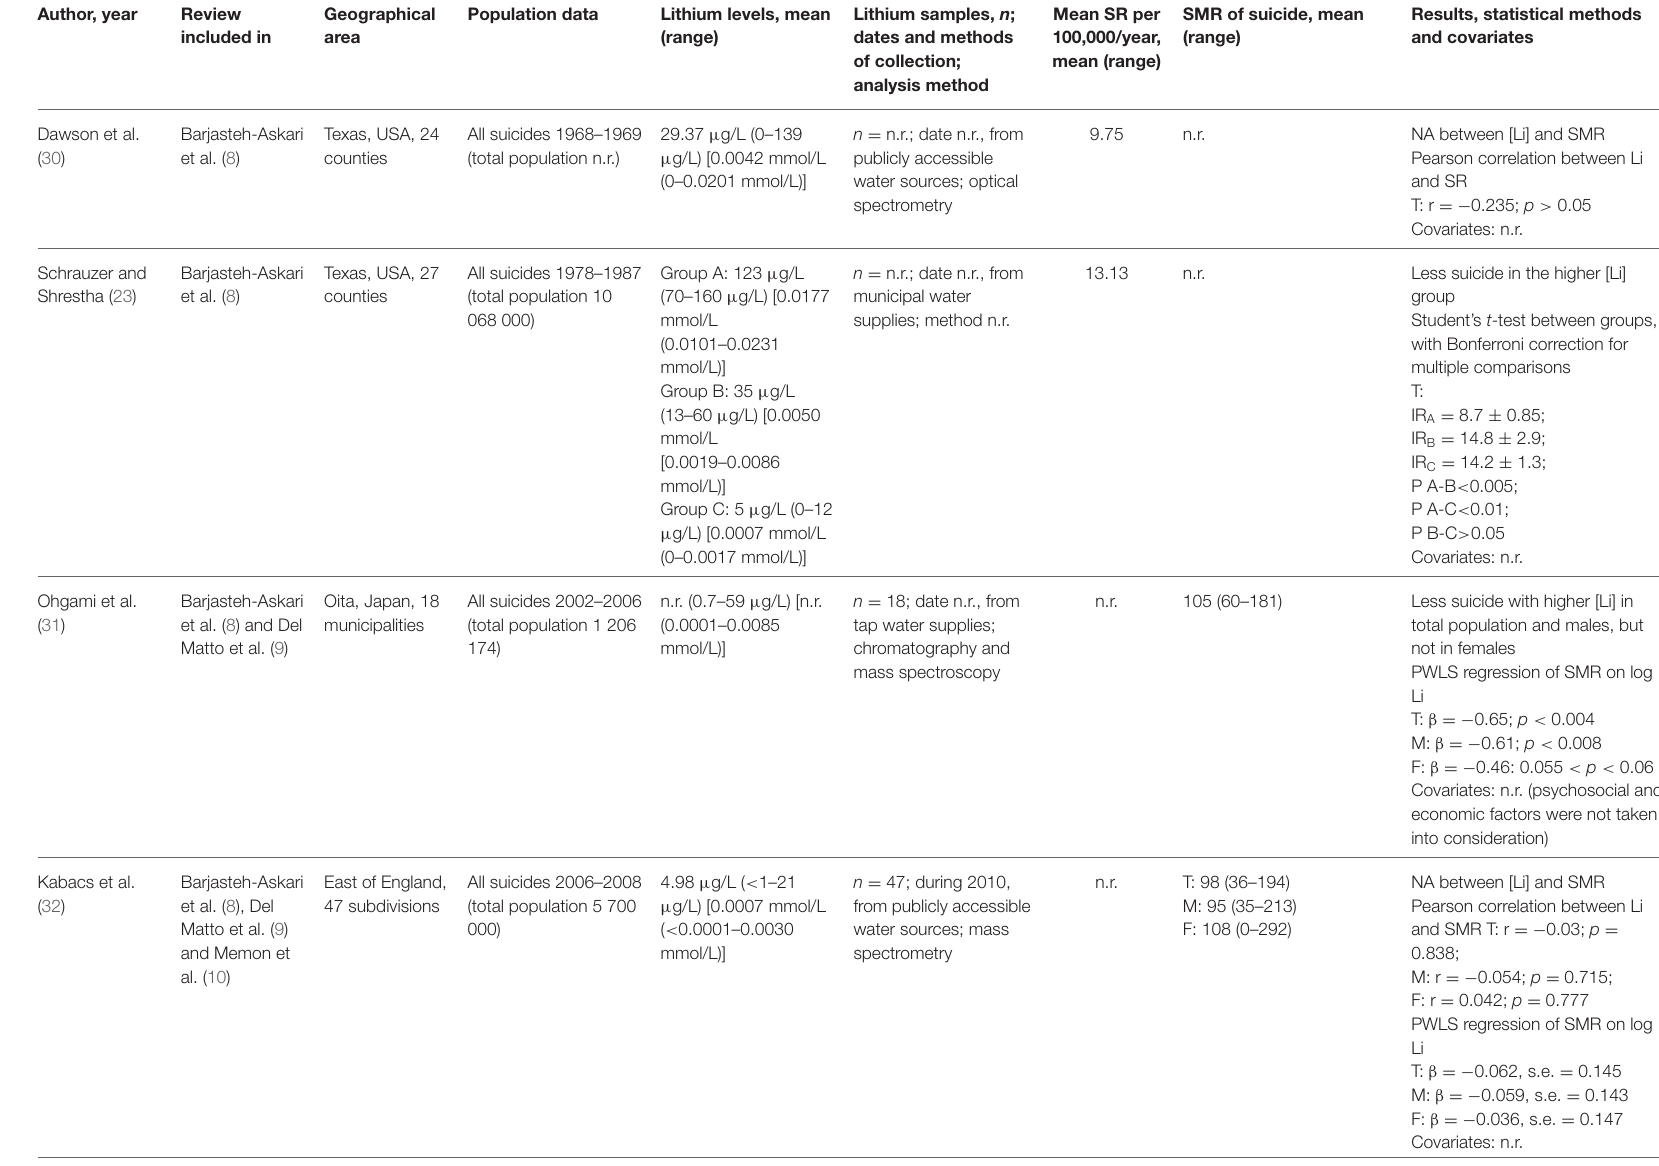
TABLE 1 | Characteristics of the studies of lithium at trace doses as a suicide protective